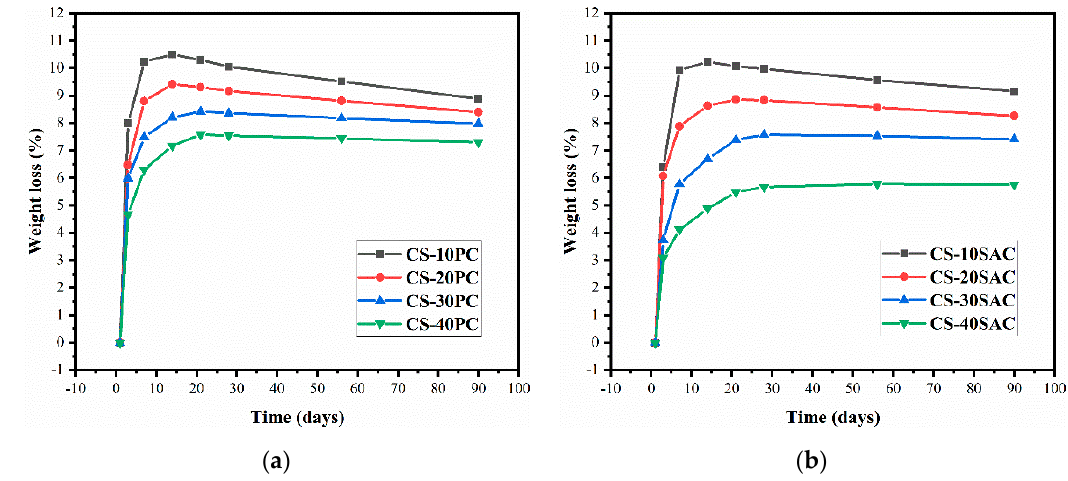
Figure 6. Weight loss of blended mortars: ( a ) CS-PC blended mortars; ( b ) CS-SAC blended mortars.